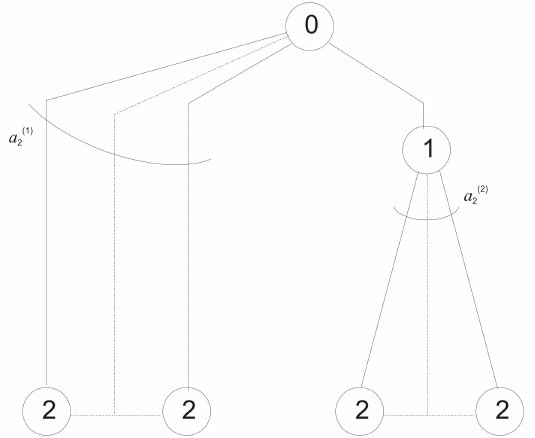
Figure 3. Contracted representation of the hierarchical ramified